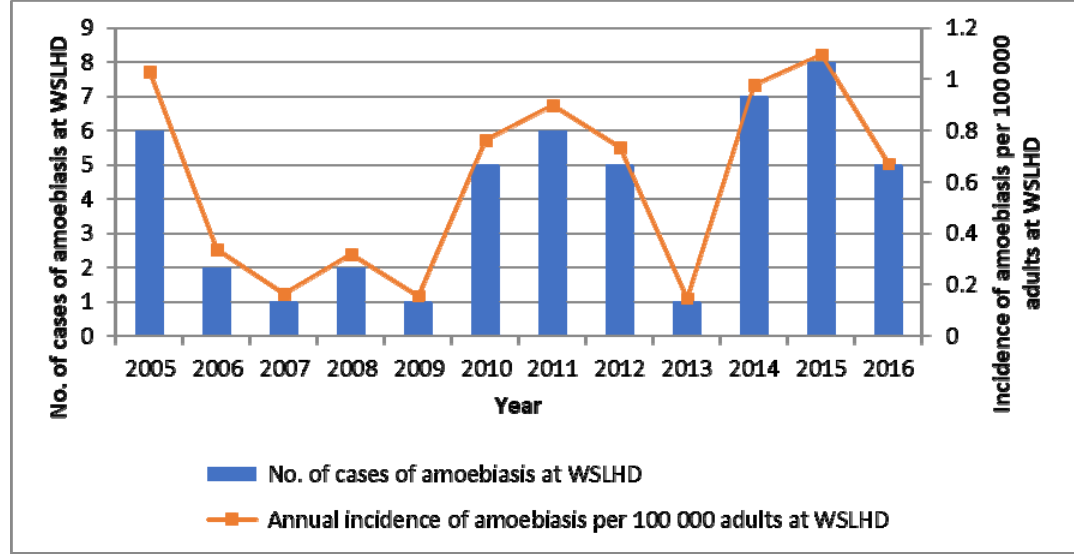
Figure 1. Incidence of invasive amoebiasis at Western Sydney Local Health District (WSLHD) between years 2005 and 2016. Population size estimates in WSLHD per year were derived from the following website: http://www.healthstats.nsw.gov.au/. Patients 15 years and over were considered adults.